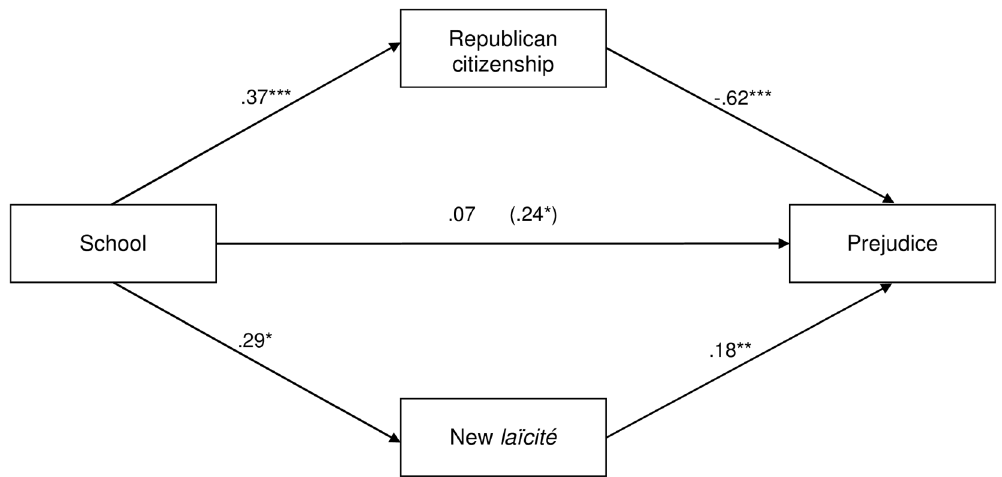
Figure 2. Effect of education on prejudice through support for republican principles. * p < .05. ** p < .01. *** p <